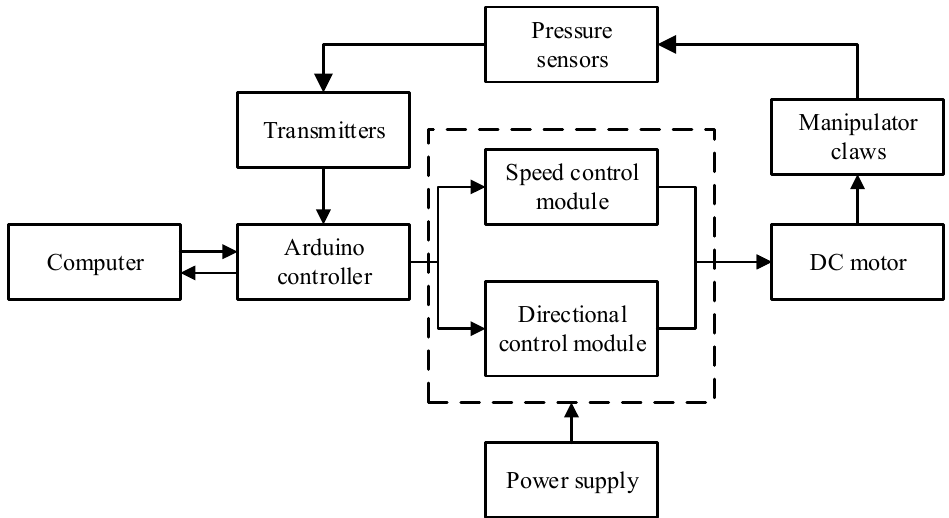
Figure 12. Schematic diagram of the control system.